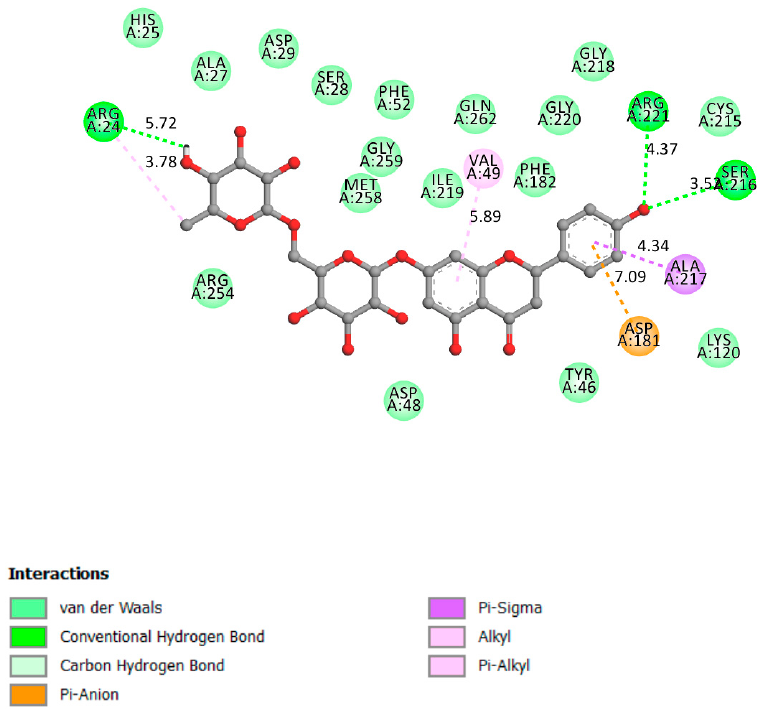
Figure 2. Two-dimensional scheme of the narirutin interactions with PTP1B.